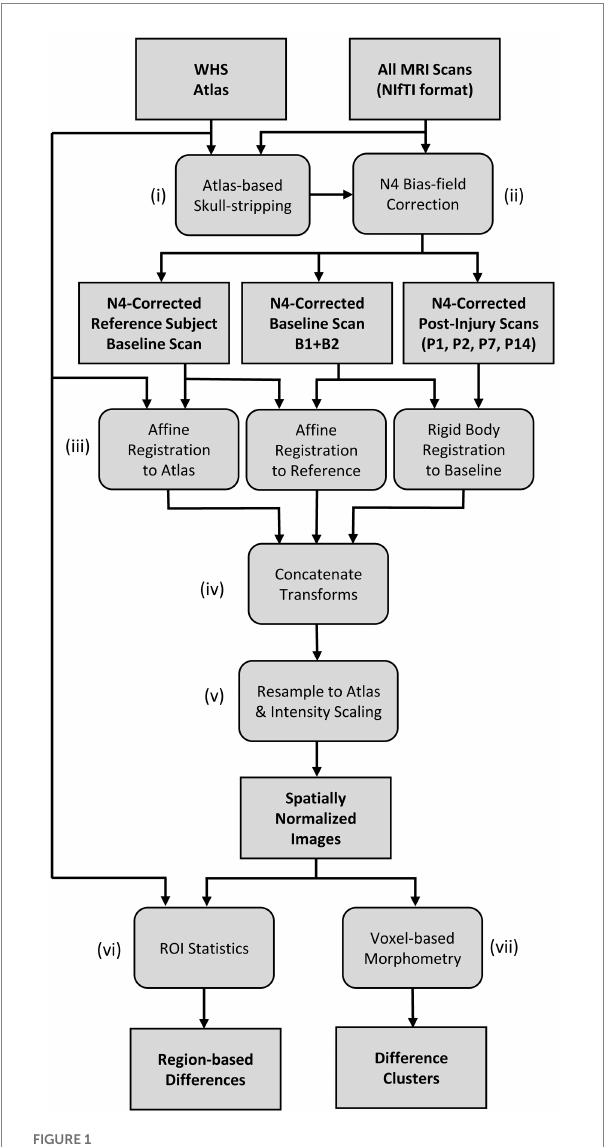
FIGURE 1 Flow-chart of the MR image processing pipeline for region- and voxel-based